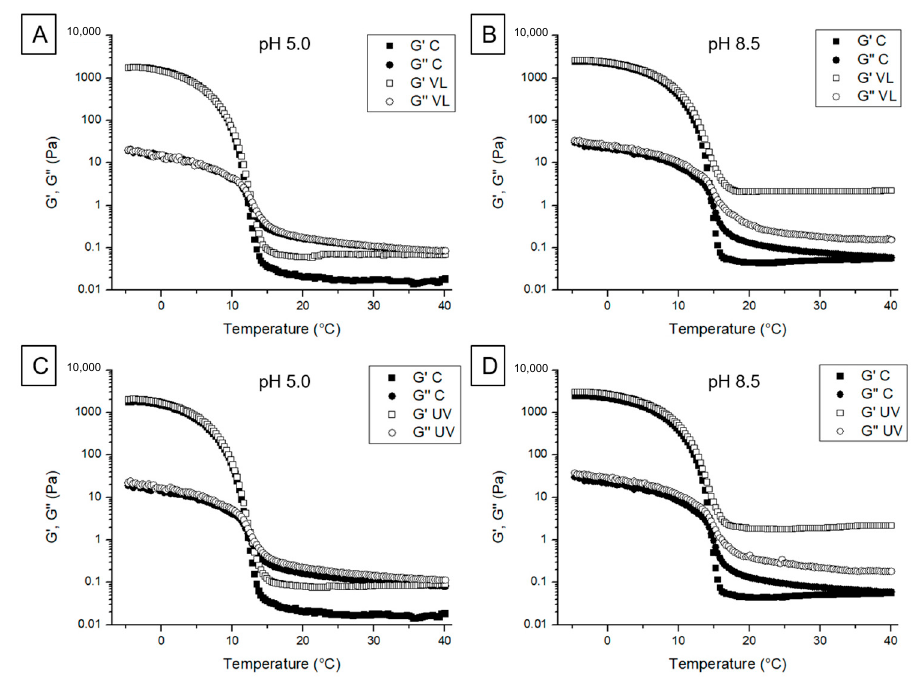
Figure 3. Storage modulus ( G ’) and the loss modulus ( G ”) of crosslinked samples upon heating. Visible light (VL): ( A ) and ( B ); ultraviolet light (UV): F ( C ) and ( D ). Control (C): no light exposure.